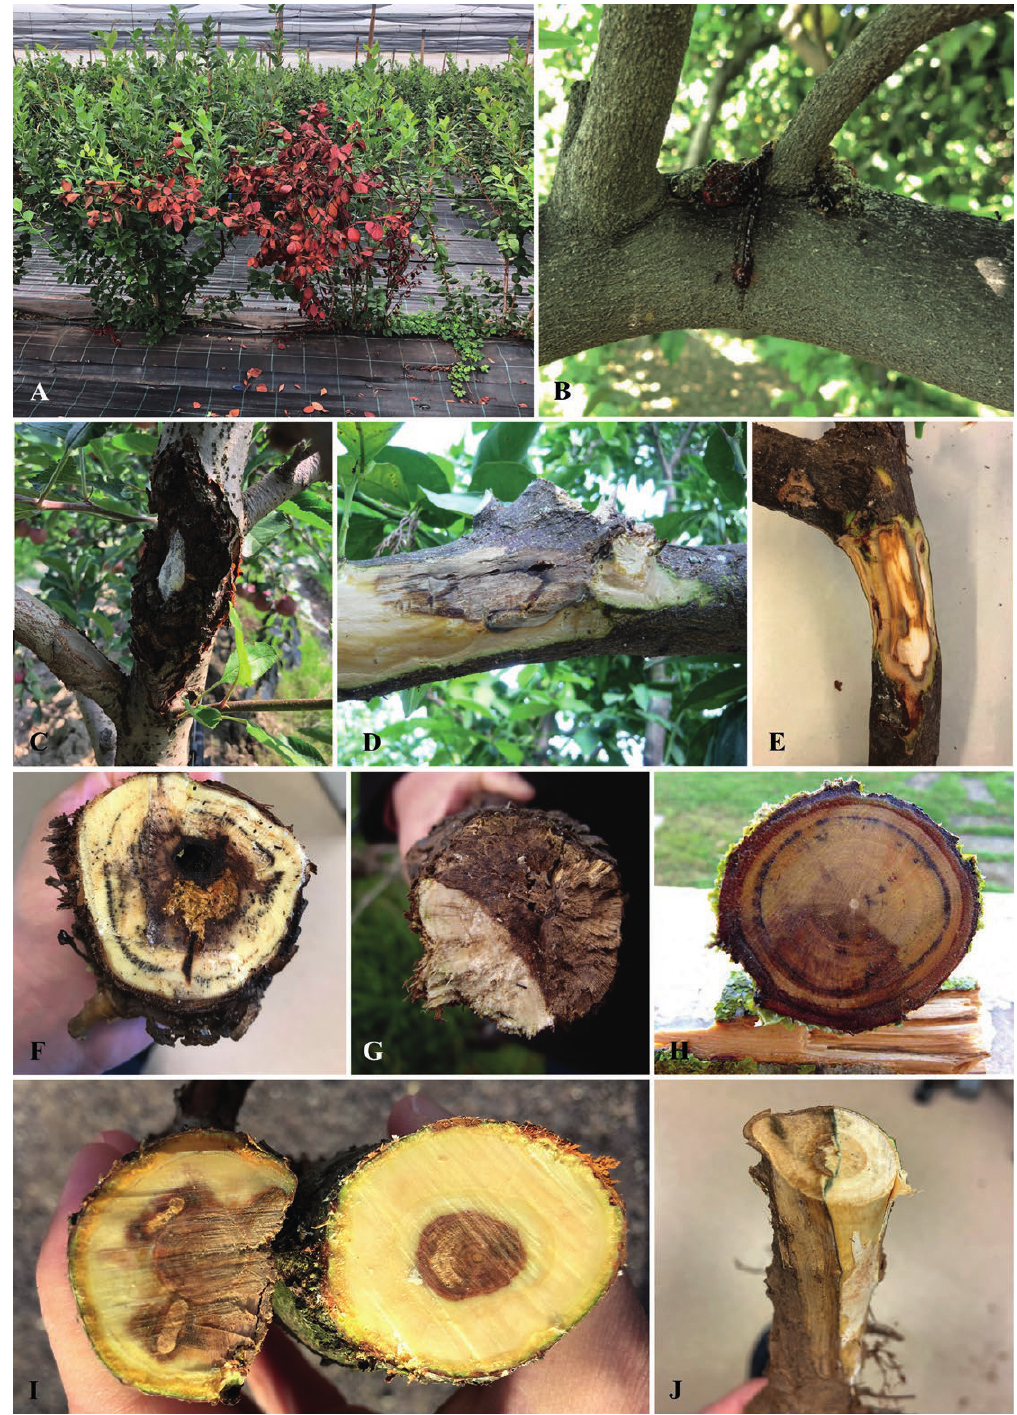
Figure 1. FTD symptoms on different fruit trees. Natural dieback of Vaccinium corymbosum ‘Blue Ribbon’ in the field ( A ); branch canker on Citrus sinensis caused by Diaporthe spp. ( B , from Guarnaccia et al ., 2020); trunk canker on apple caused by Neonectria ditissima ( C ); internal discolouration of Citrus reticulata branch affected by Botryosphaeriaceae ( D , from Bezerra et al ., 2022); internal discolouration of avocado twig caused by Neofusicoccum spp. ( E ); cross-section showing a central white rot surrounded by black spots and sectorial necrosis of an esca infected vine ( F ), wedge-shaped canker in a Eutypa dieback affected vine ( G ), black spots and dark brown to black streaking of the xylem tissue in almond branches ( H ), sectorial necrosis of walnut affected trees ( I ), wood discolouration in pear branches ( J